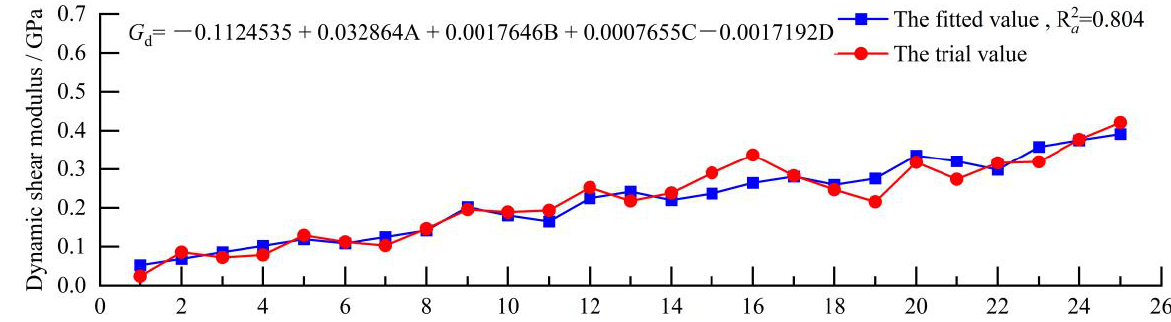
Figure 9. Comparison of fitting and experimental results for dynamic shear modulus.